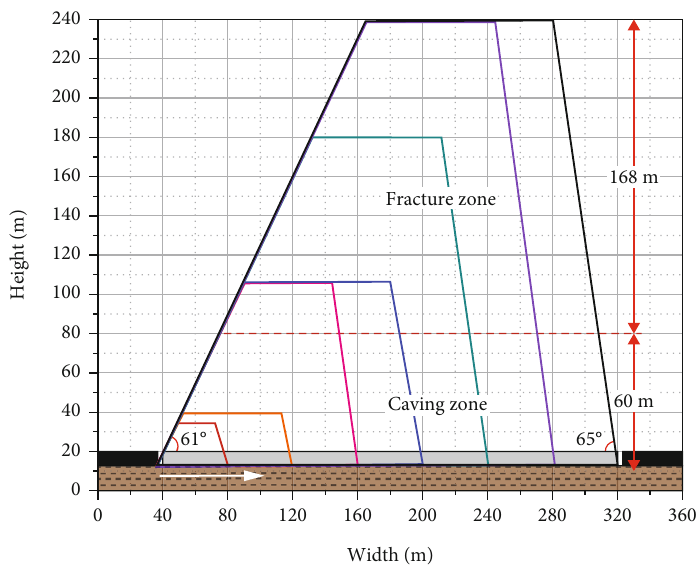
Figure 12: Evolution characteristics of overburden migration failure fracture range.